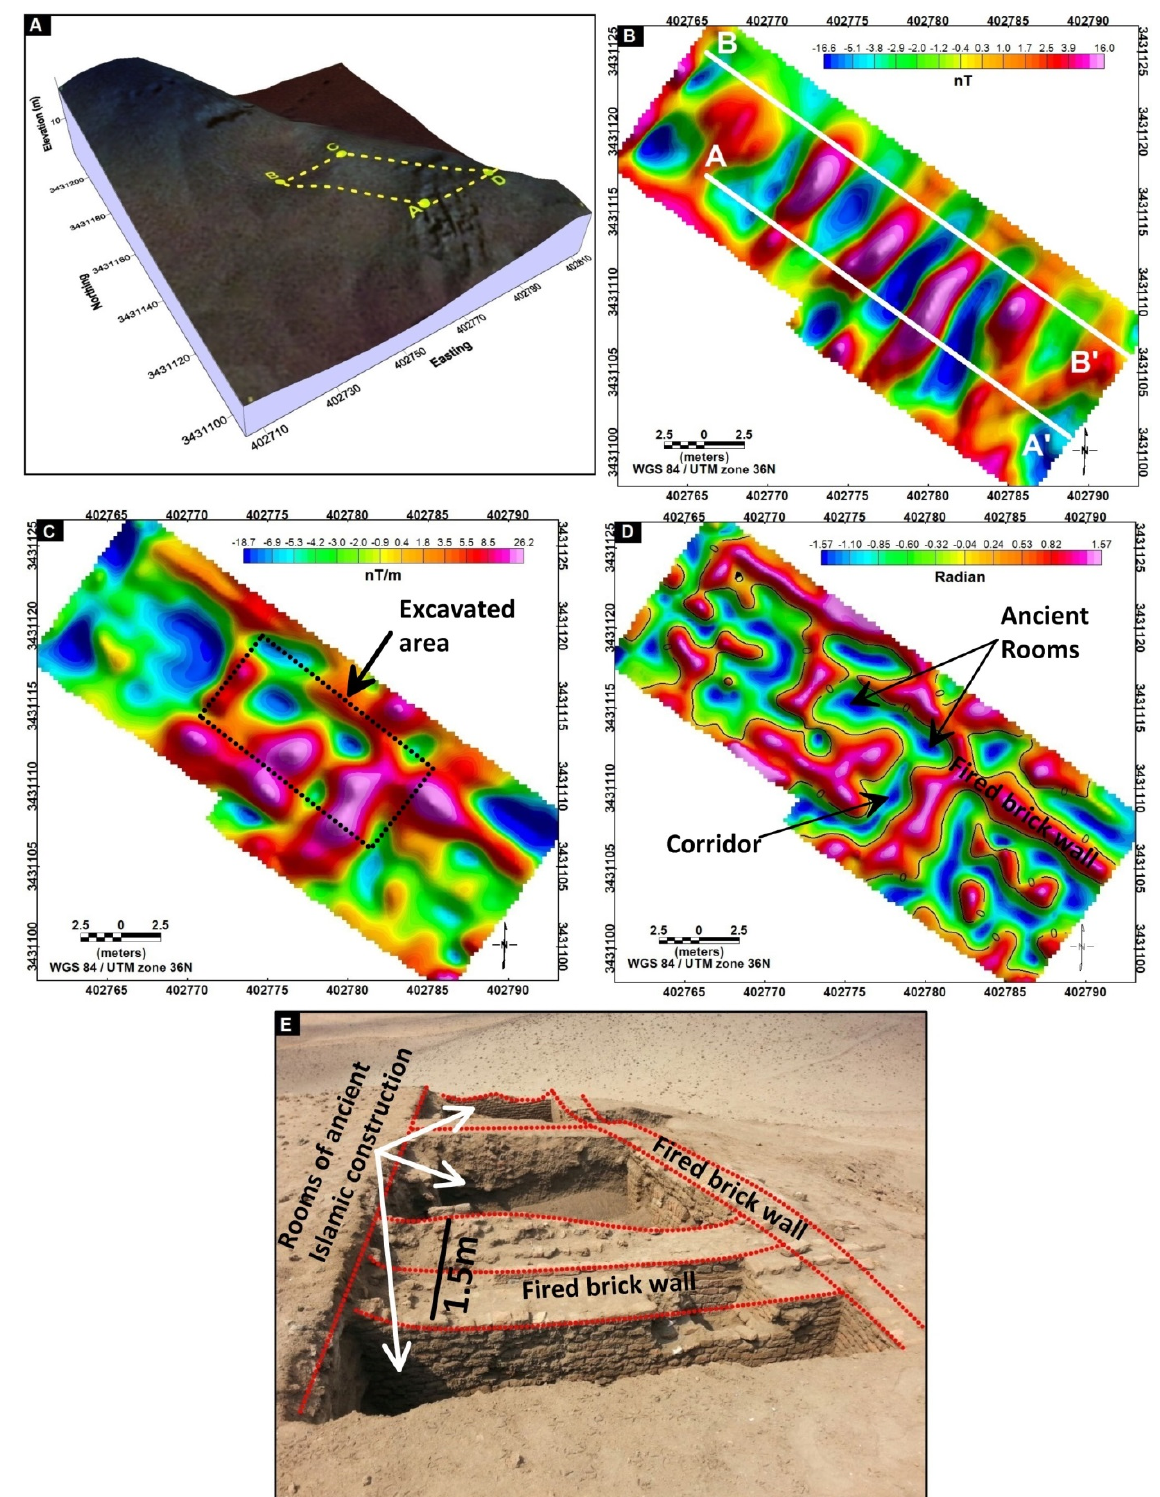
Figure 8. Magnetic results of the area around Spot B: (A) 3D geometry of the actual location of the surveyed area; (B) Butterworth filtered (Ft) map; (C) vertical magnetic gradient using sensors spaced 1.2 m apart; (D) tilt angle derivative of the vertical magnetic gradient; and (E) photo of excavation; dotted lines represent the boundaries of fired brick walls.